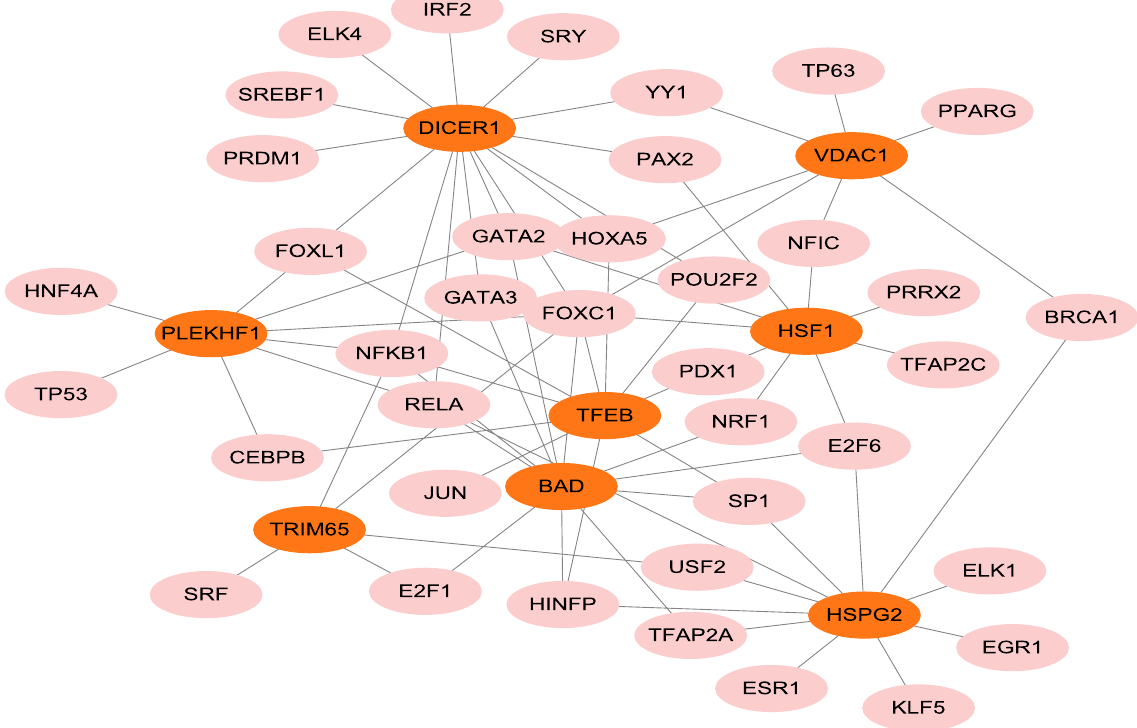
Figure 7. Network of transcription factors interacting with 8 potential diagnostic biomarkers. The highlighted orange nodes indicated the 8 potential diagnostic biomarkers and the other pink nodes indicated transcription factors. The network consisted of 8 core genes, 46 nodes and 76 edges.